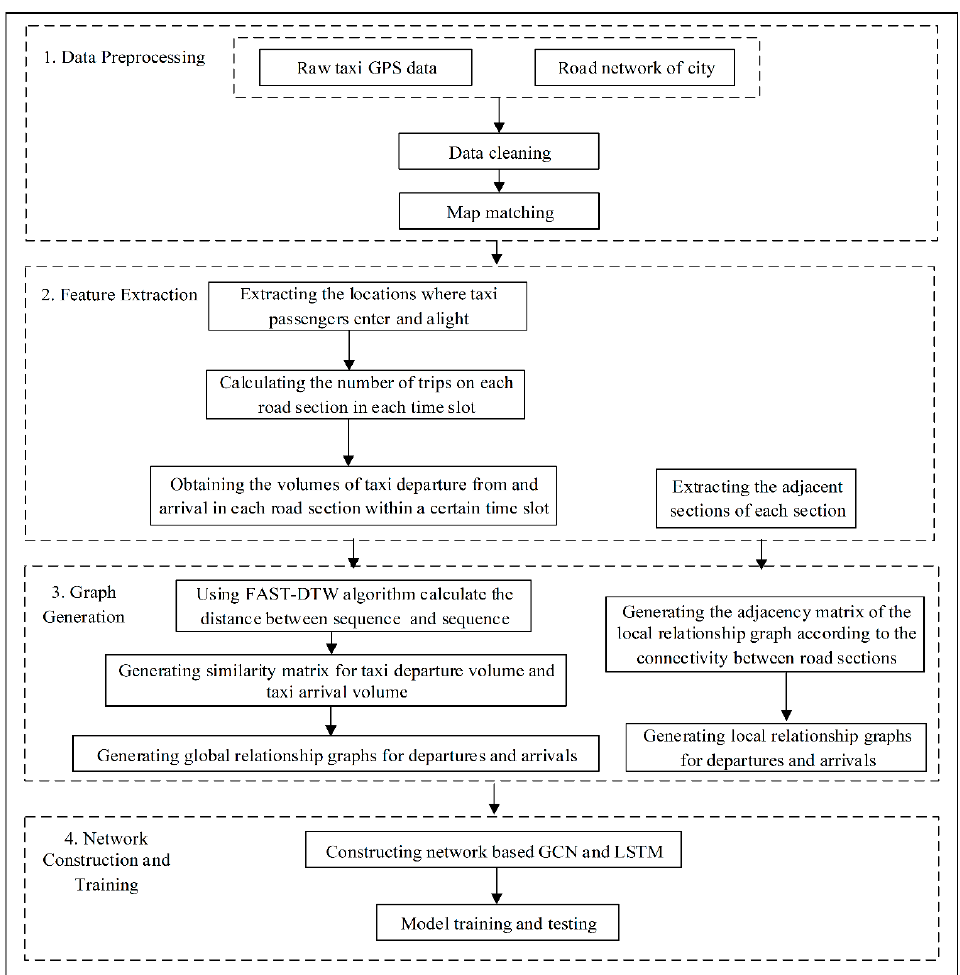
Figure 3. The overall framework of the proposed method.